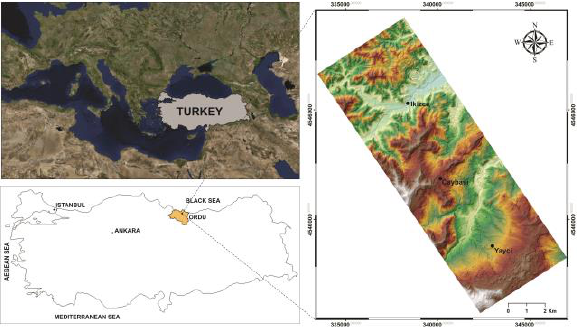
Figure 2. The study area location (left) and the DTM (right) with upper left coordinates: 41,0944  N, 37,0178  E; and the lower right coordinates: 40,9500  N, 37,1814 